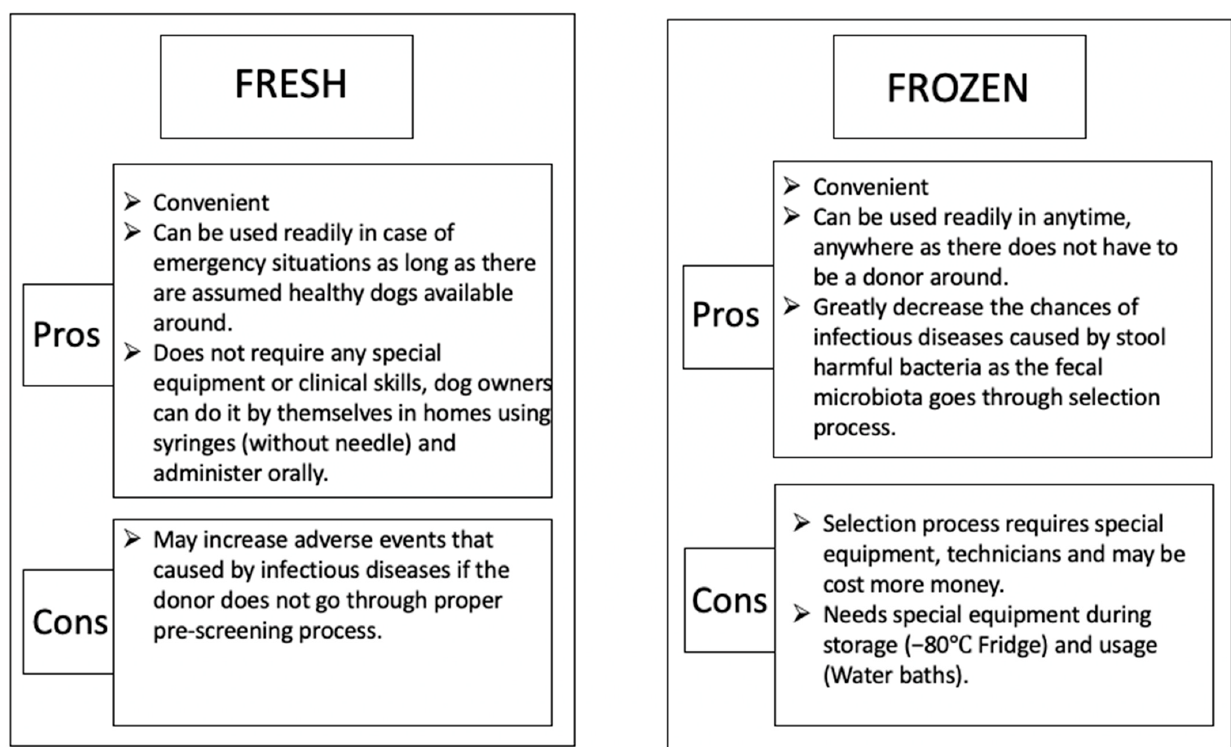
Figure 7. Pros and cons of preparing fresh and frozen stools for canine FMT treatment.